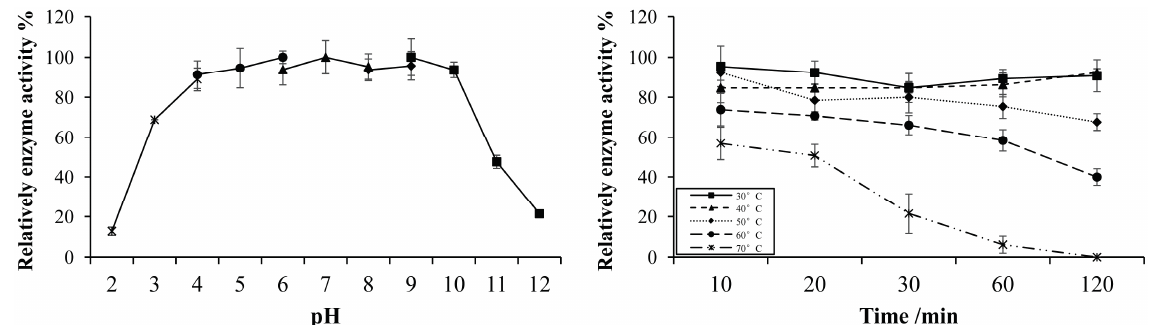
Figure 8. Optimal pH and temperature for the activities of recombinant xynGH11-7.